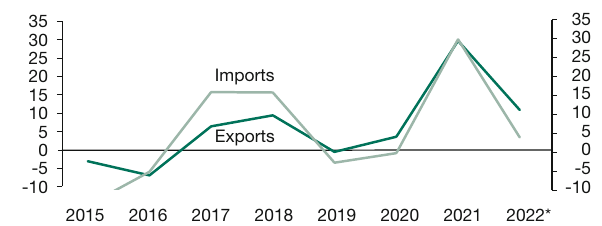
in %, year-on-year